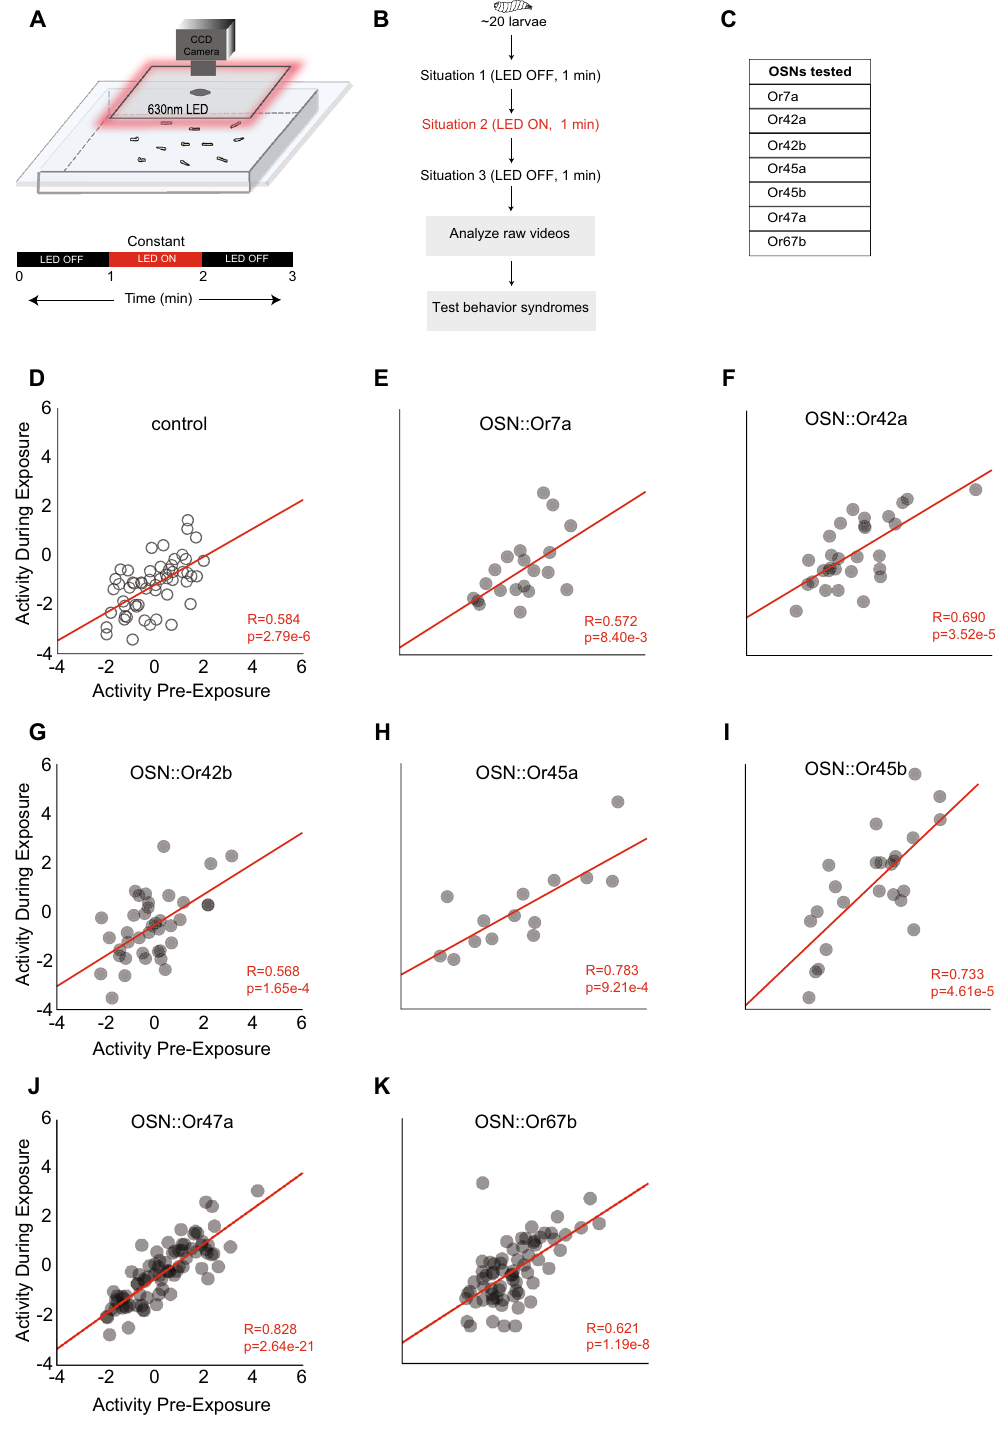
Figure 3. Experiment 3: Influence of sensory neurons on olfactory behavior syndromes. ( A ) ~ 20 transgenic larvae, each expressing ChRhodopsin in a single pair of olfactory sensory neurons (OSNs), are allowed to roam freely on an agarose arena. OSNs expressing ChRhodopsin are activated by shining red light (630 nm) on the arena. Larvae are subjected to three situations: situation 1 (pre-exposure: lights OFF, 1 min.); situation 2 (during-exposure: lights ON, 1 min.); situation 3 (post-exposure: lights OFF, 1 min.). Larval movements are recorded by a CCD camera. Adapted from Clark et al. 31 . The assay is repeated 5 times for each set of OSNs targeted and control animals. ( B ) A schematic of the paradigm and ( C ) a list of seven OSNs targeted in this study are provided on the right. ( D-K ) Correlations between the activity of larva in situation 1 (pre-exposure) and its activity in situation 2 (during exposure) are shown for ( D ) control larvae, p = 2.79e -6 , n = 55, and for larvae in which the following OSNs are activated: ( E ) OSN::Or7a, p = 8.40e -3 , n = 20; ( F ) OSN::Or42a, p = 3.25e -5 , n = 28; ( G ) OSN::Or42b, p = 1.65e -4 , n = 39; ( H ) OSN::Or45a, p = 9.21e -4 , n = 14; ( I ) OSN::45b, p = 4.61e -5 , n = 25; ( J )